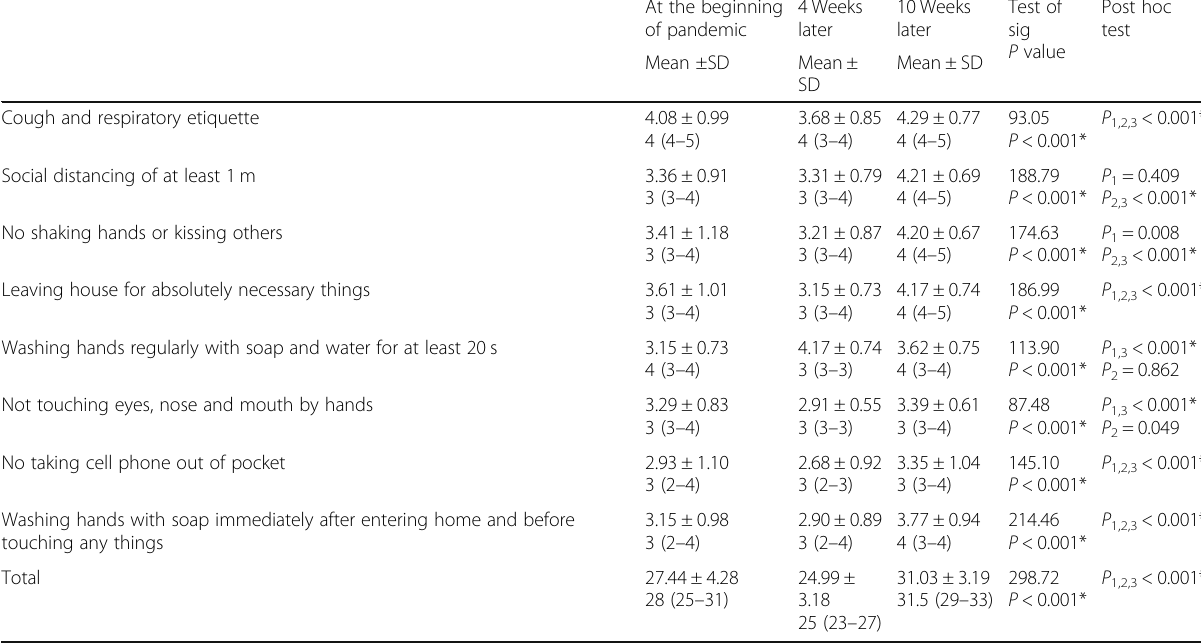
Table 3 Distribution of preventive behaviours from COVID-19 over the three periods of time